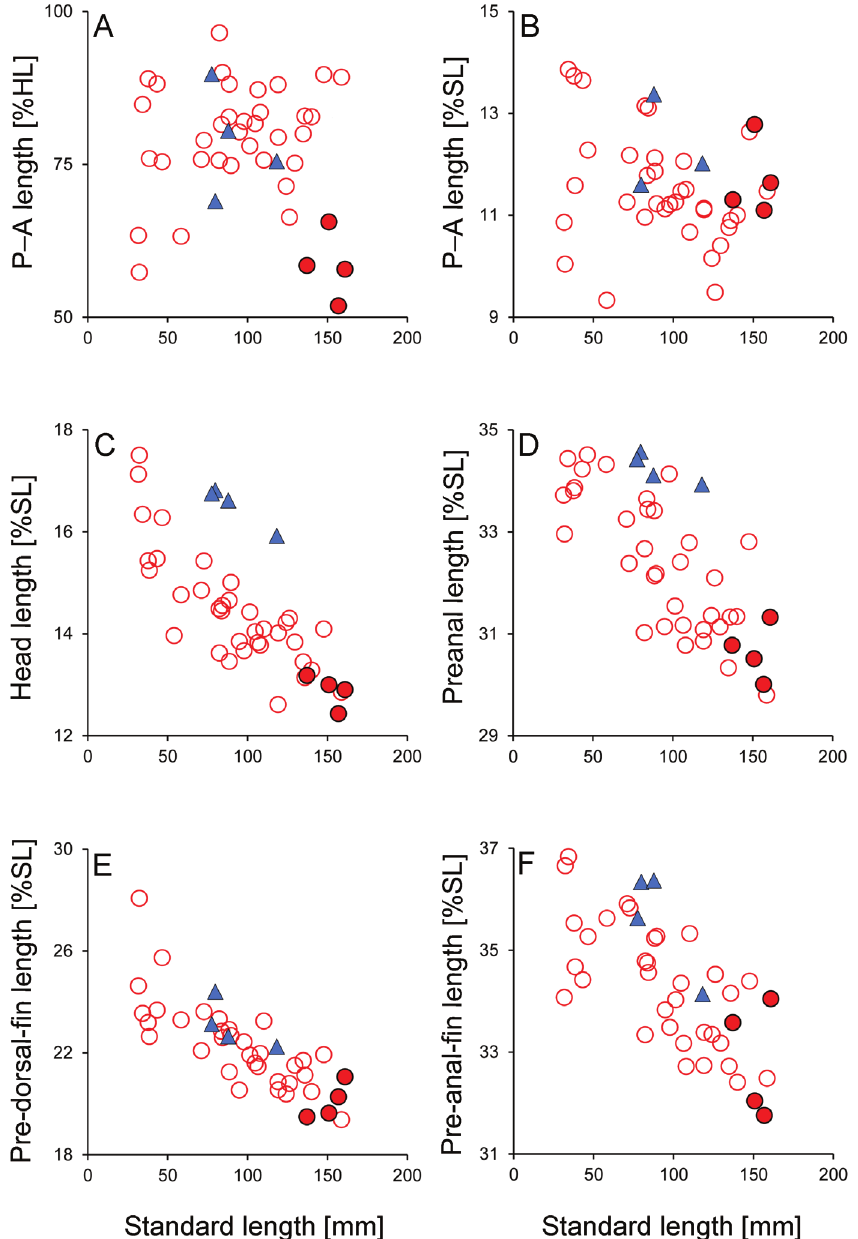
Figure 3. Relations of P–A length ( A ), as % of head length (mm), and P–A length ( B ), head length ( C ), Pre-anal length ( D ), pre- dorsal-fin length ( E ), and preanal-fin length ( F ) as % of standard length [mm] of Taenioides anguillaris and T. snyderi . Closed red circles: Taenioides snyderi (Taiwan); open red circles: T. snyderi (Japan); blue triangles: T. anguillaris (Japan). Data for T. anguil- laris and T. snyderi from Koreeda and Motomura (2021) and Miyahira and Tachihara